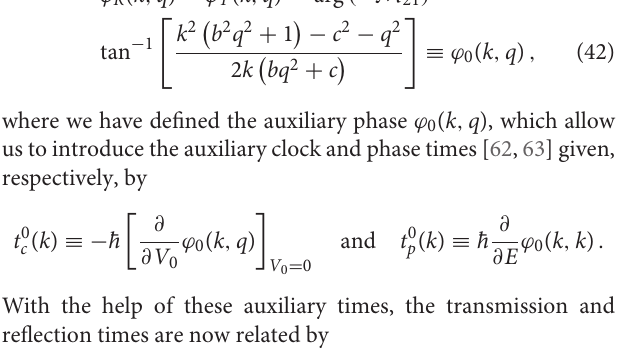
Frontiers in Physics |